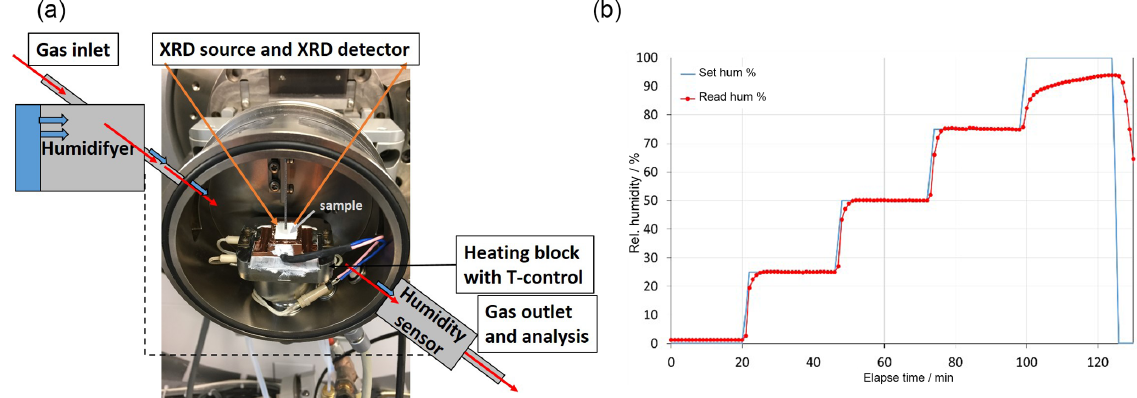
Figure 2. Schematic of the humidity chamber mounted to the XRD instrument (a) . Log file data to illustrate the successive humidity increase with time (b) . XRD measurements were performed during the relative humidity